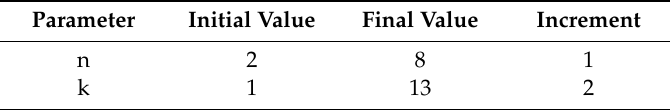
Table 3. Initial, final values and increments of the measured